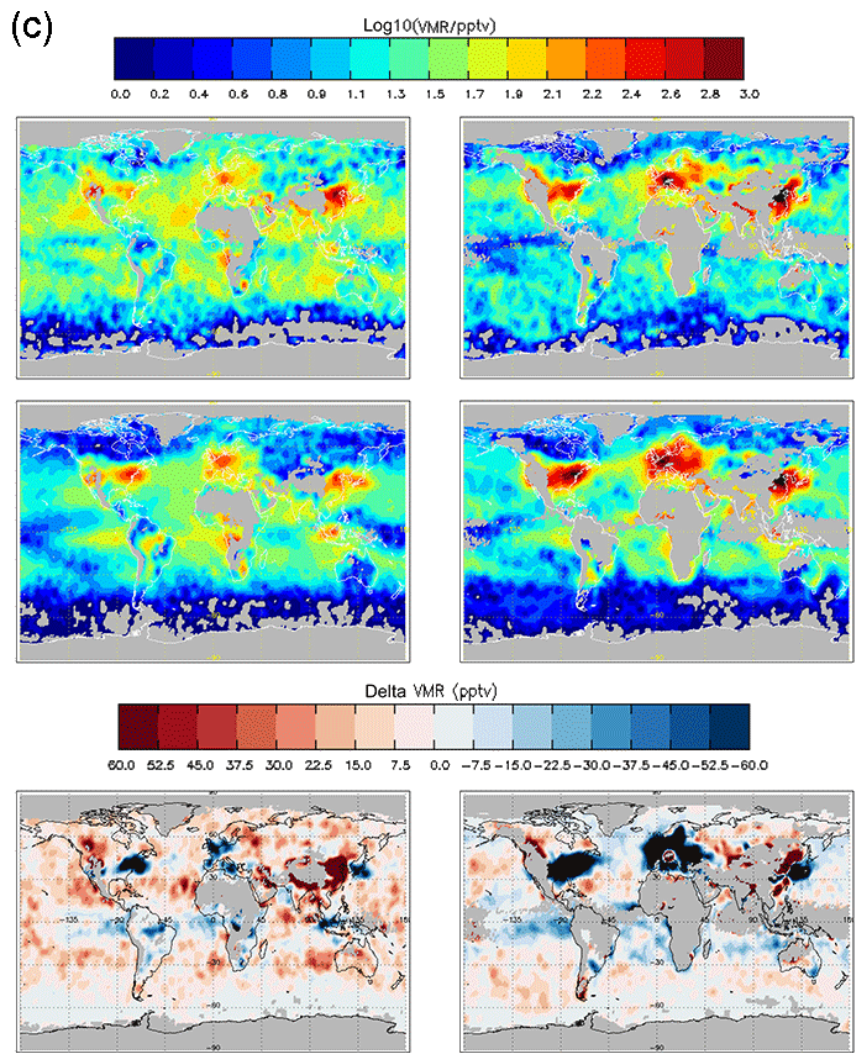
Figure 5. (a) Upper cloud levels (280hPa left, 380hPa right): OMI vs. model NO 2 VMRs (OMI top, TM4 middle, difference bottom) average quantities for the year 2006. (b) Same as (a) but for middle cloud levels (500hPa left, 620hPa right). (c) Same as (a) but for lower cloud levels (720hPa left, 820hPa